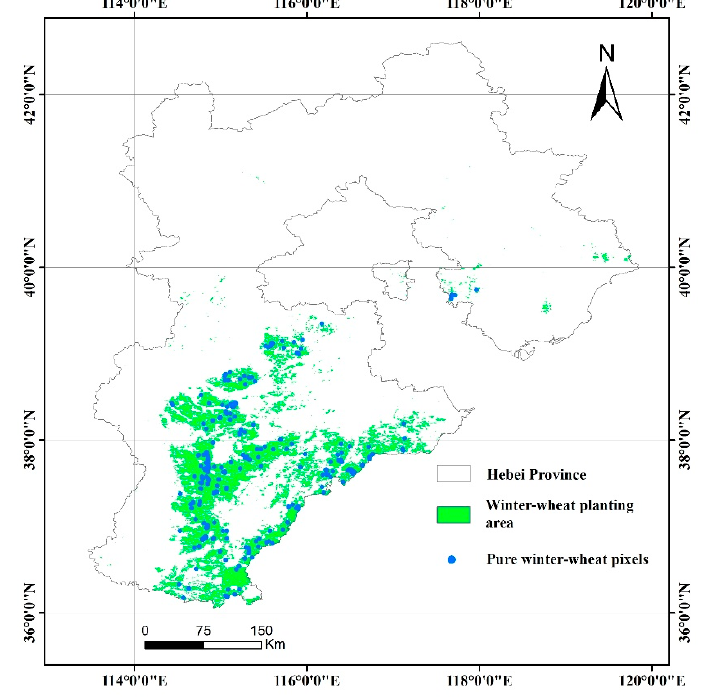
Figure 7. Winter wheat distribution and pure winter-wheat pixels.